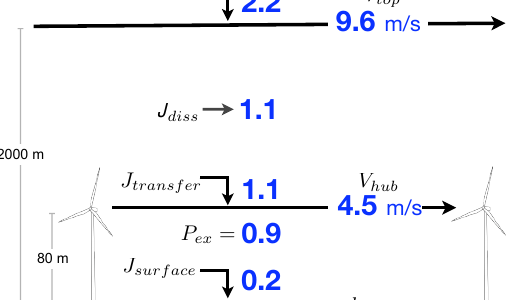
Fig. 3. Comparison of the kinetic energy fluxes for the 3 different assumptions using a turbine spacing of A turbine =10 D · 3 D , where D =61m is the rotor diameter. Unless otherwise noted, all quanti- ties have the units Wm − 2